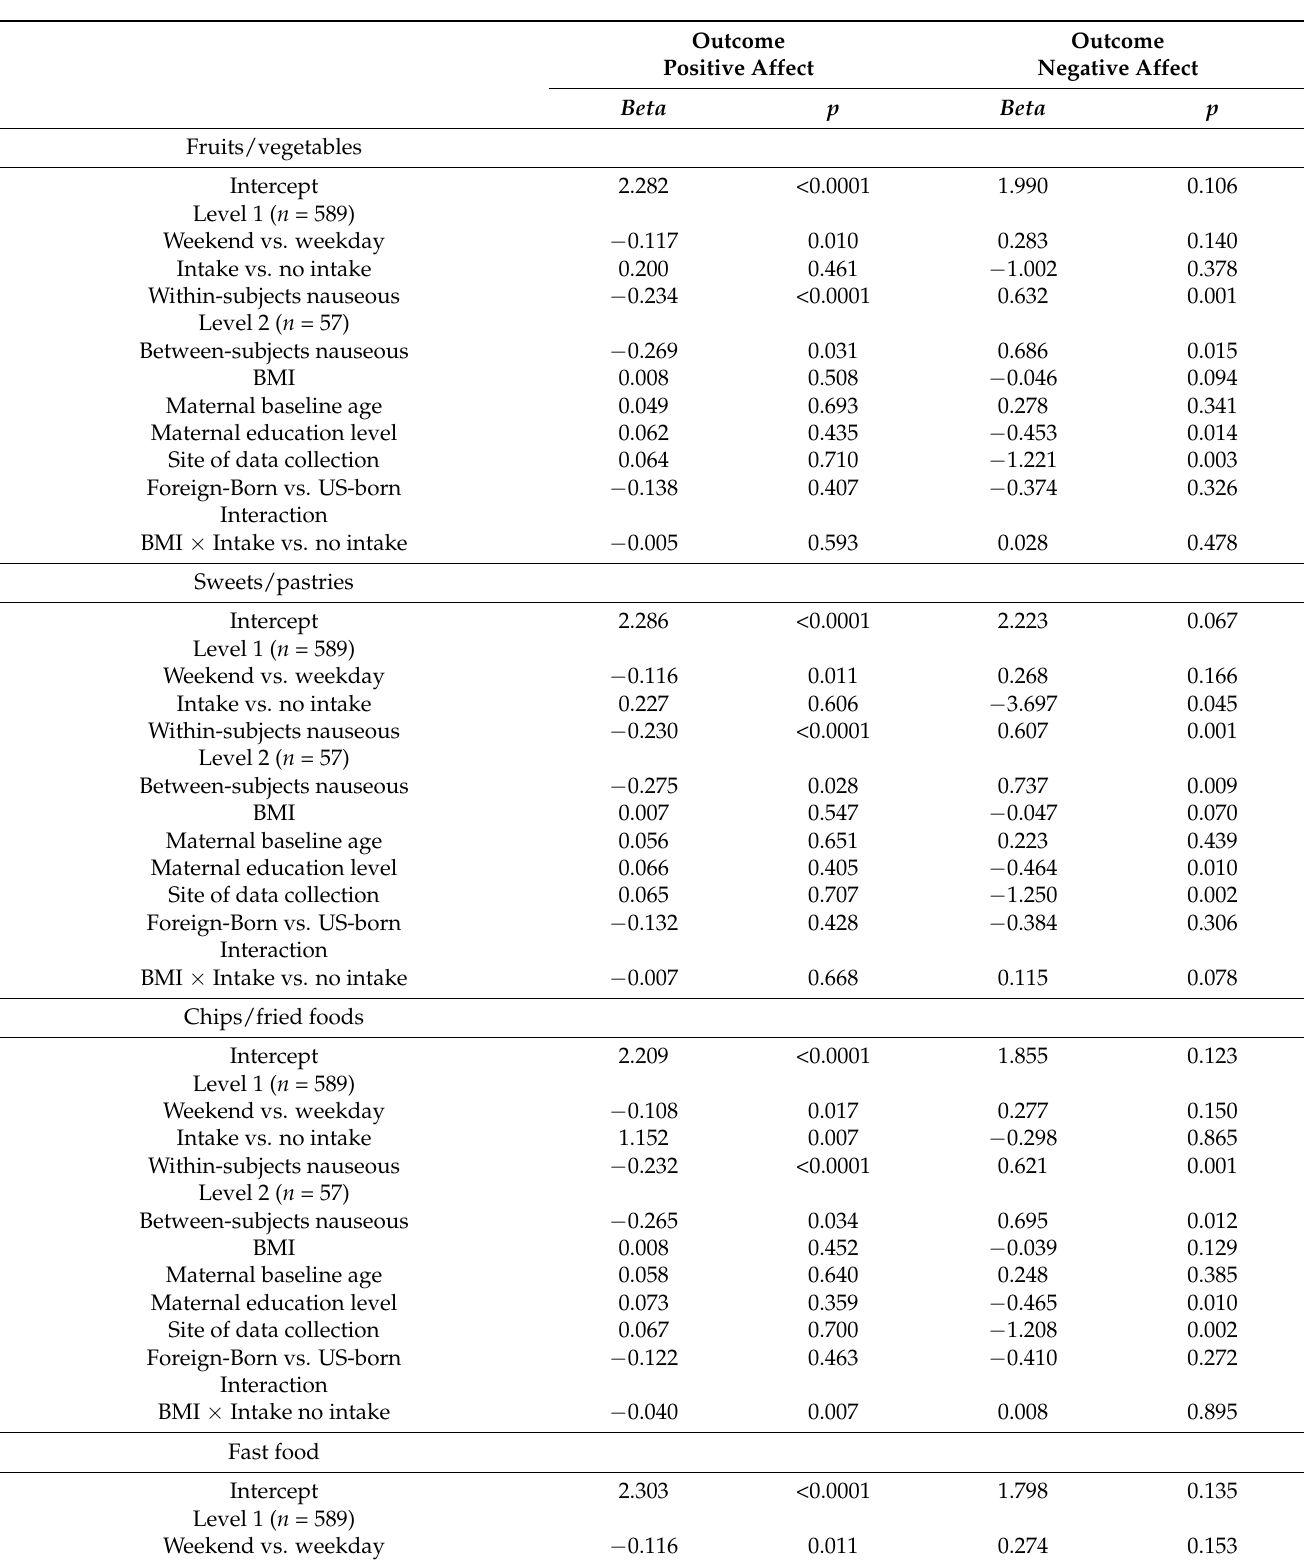
Table 3. Results of Multilevel Models of Food Intake Predicting